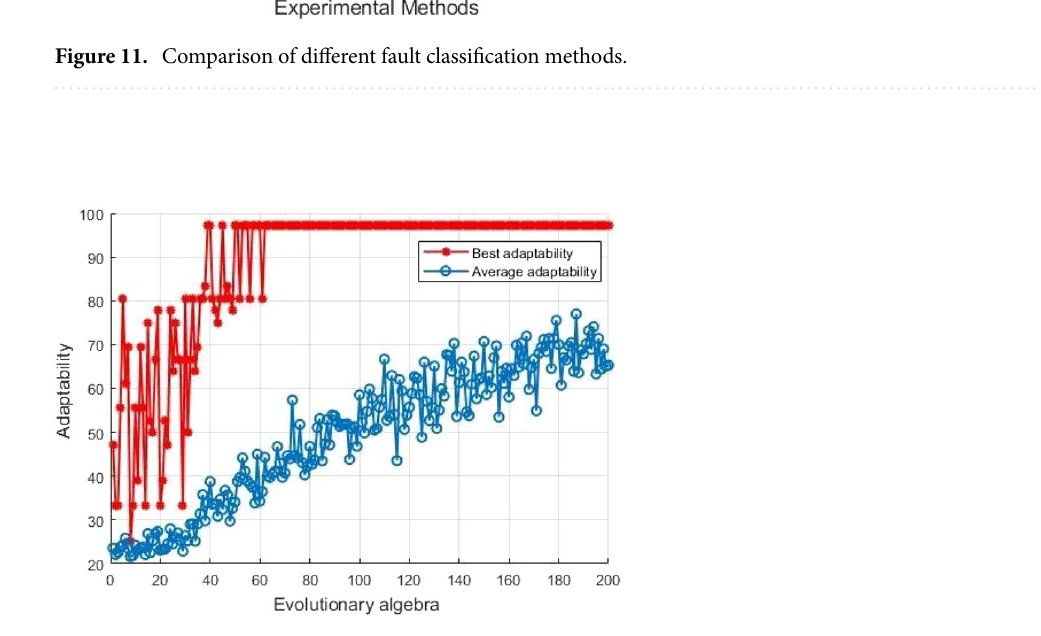
Figure 12. The result of QGA optimizing SVM